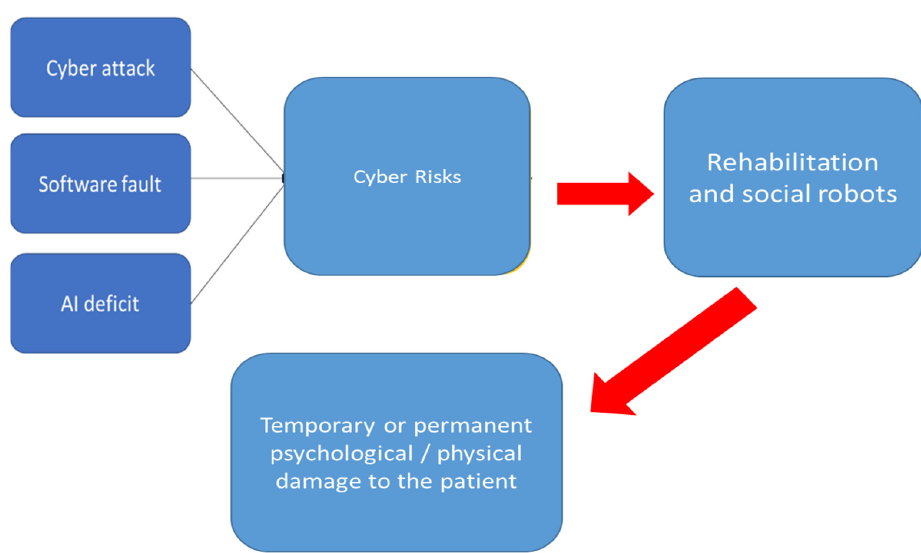
Figure 1. Model of health risks for the CRs.